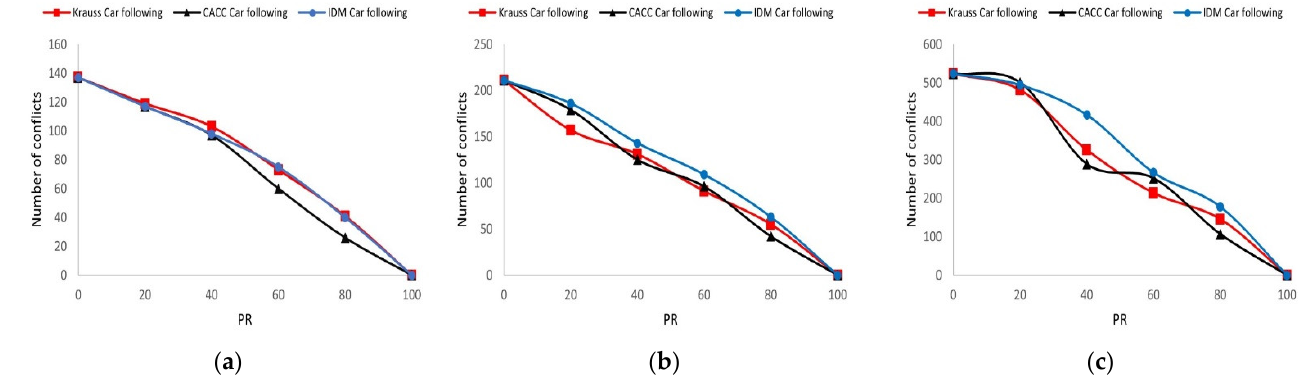
Figure 8. Number of conflicts based on different demands: ( a ) Demand = 1200 Veh/h; ( b ) Demand = 1500 Veh/h; ( c ) Demand = 1800 Veh/h.